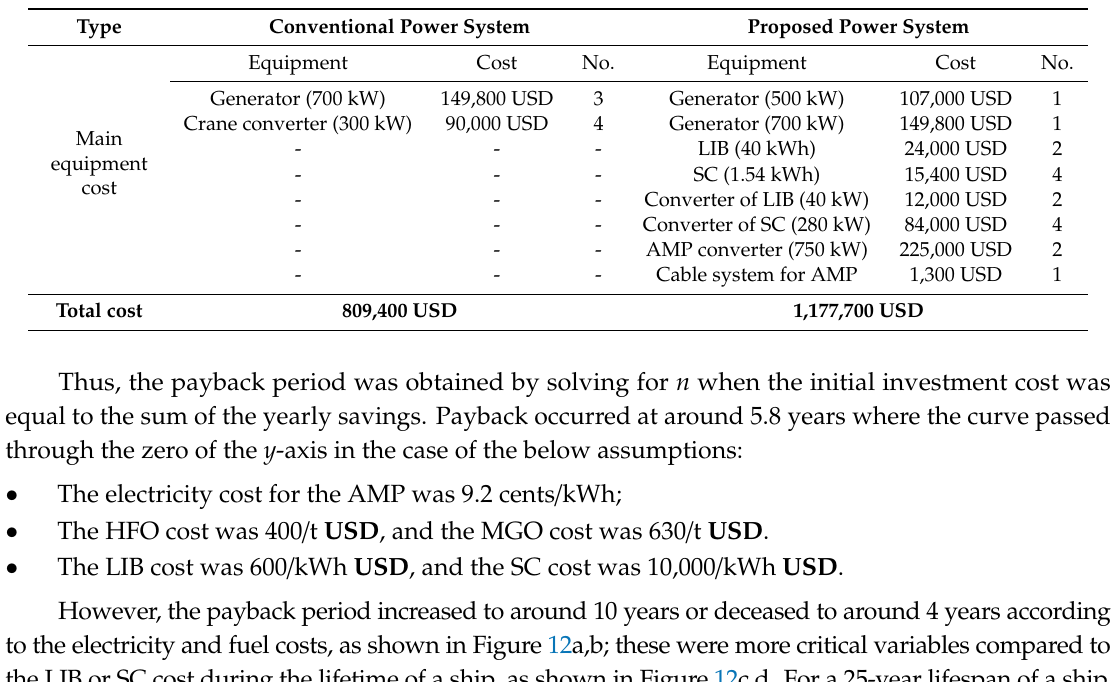
Table 19. Comparison of the operational expenditure (OPEX) for each system per year. Table 18. Comparison of the capital expenditure (CAPEX) for each system.